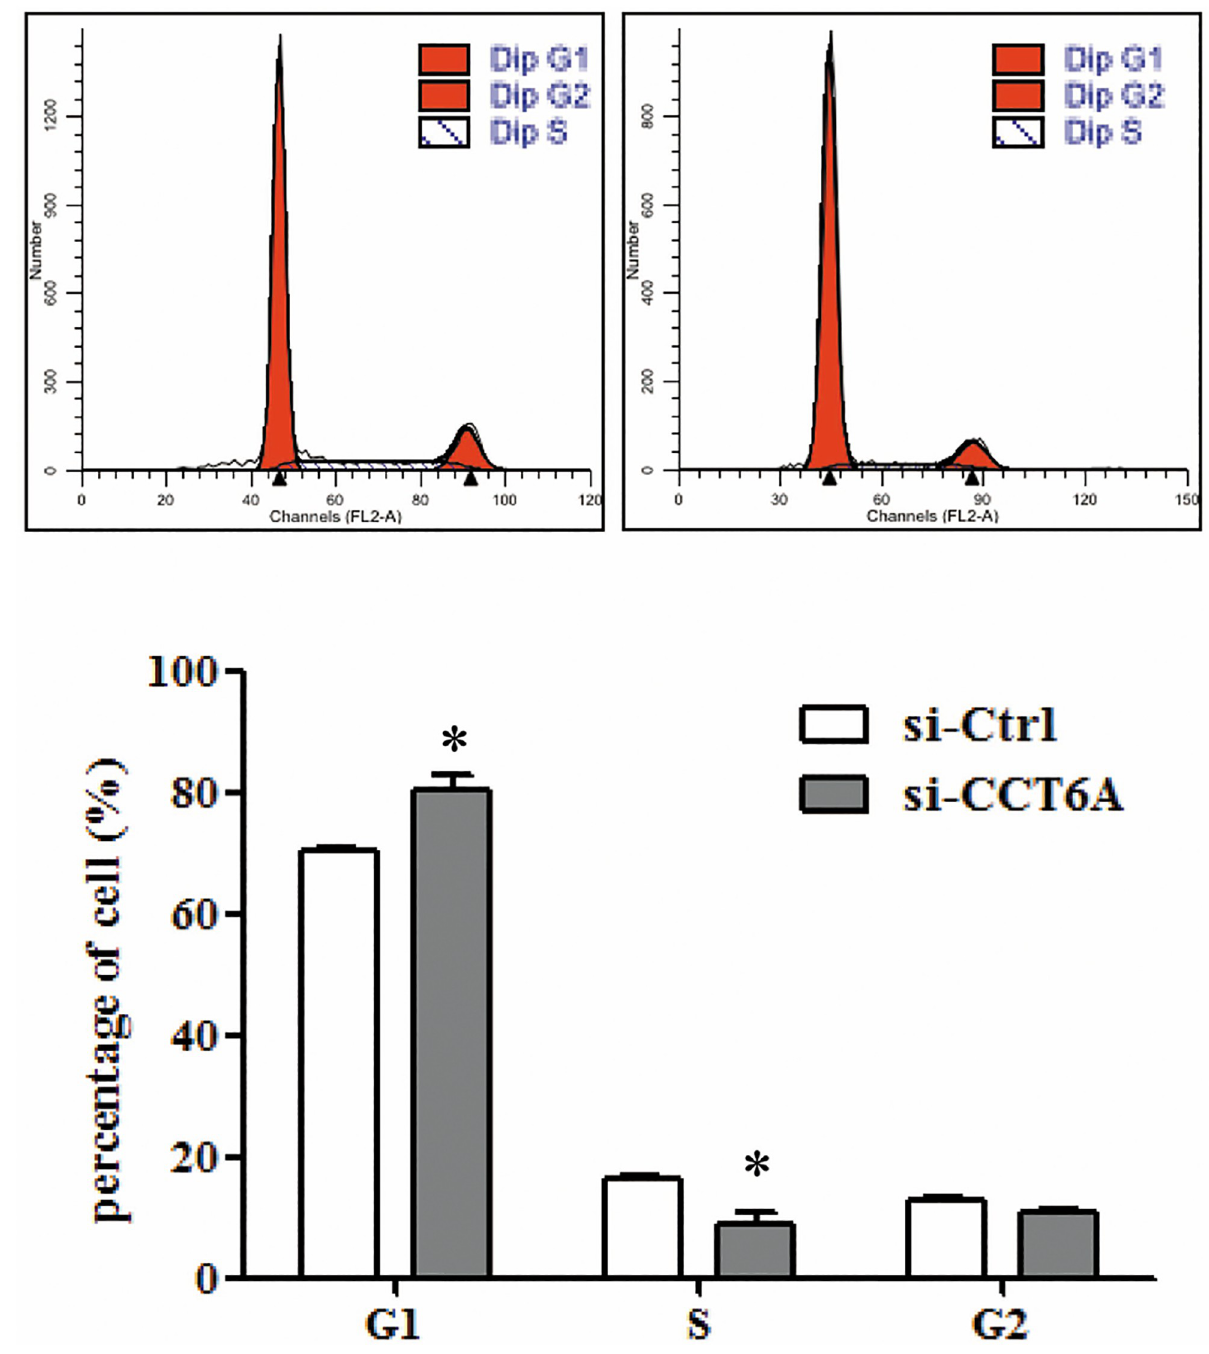
Fig 4. The effect of CCT6A on U-2 osteosarcoma cell cycle progression. After transfection with si-Ctrl or si-CCT6A-3 for 72 h, U-2 osteosarcoma cells were stained with PI solution, and cell cycle distribution was analyzed using flow cytometry. The percentages of cells in the G0/G1, S, and G2/M phases were counted. Data are presented as mean ( ± SD). n = 3. � p < 0.05 vs. si-Ctrl. CCT6A, chaperonin-containing TCP1 subunit 6A; PI, propidium iodide; SD, standard deviation; siCT6A-3, CCT6A siRNA; si-Ctrl, control siRNA; siRNA, small interfering ribonucleic acid.